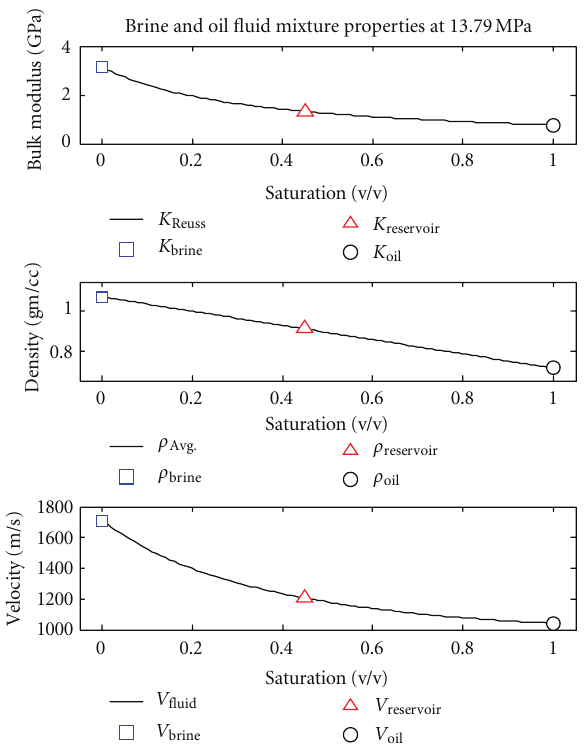
Figure 15: Calculated fluid properties at reservoir conditions for live oil, brine, and a mixture with a brine saturation of